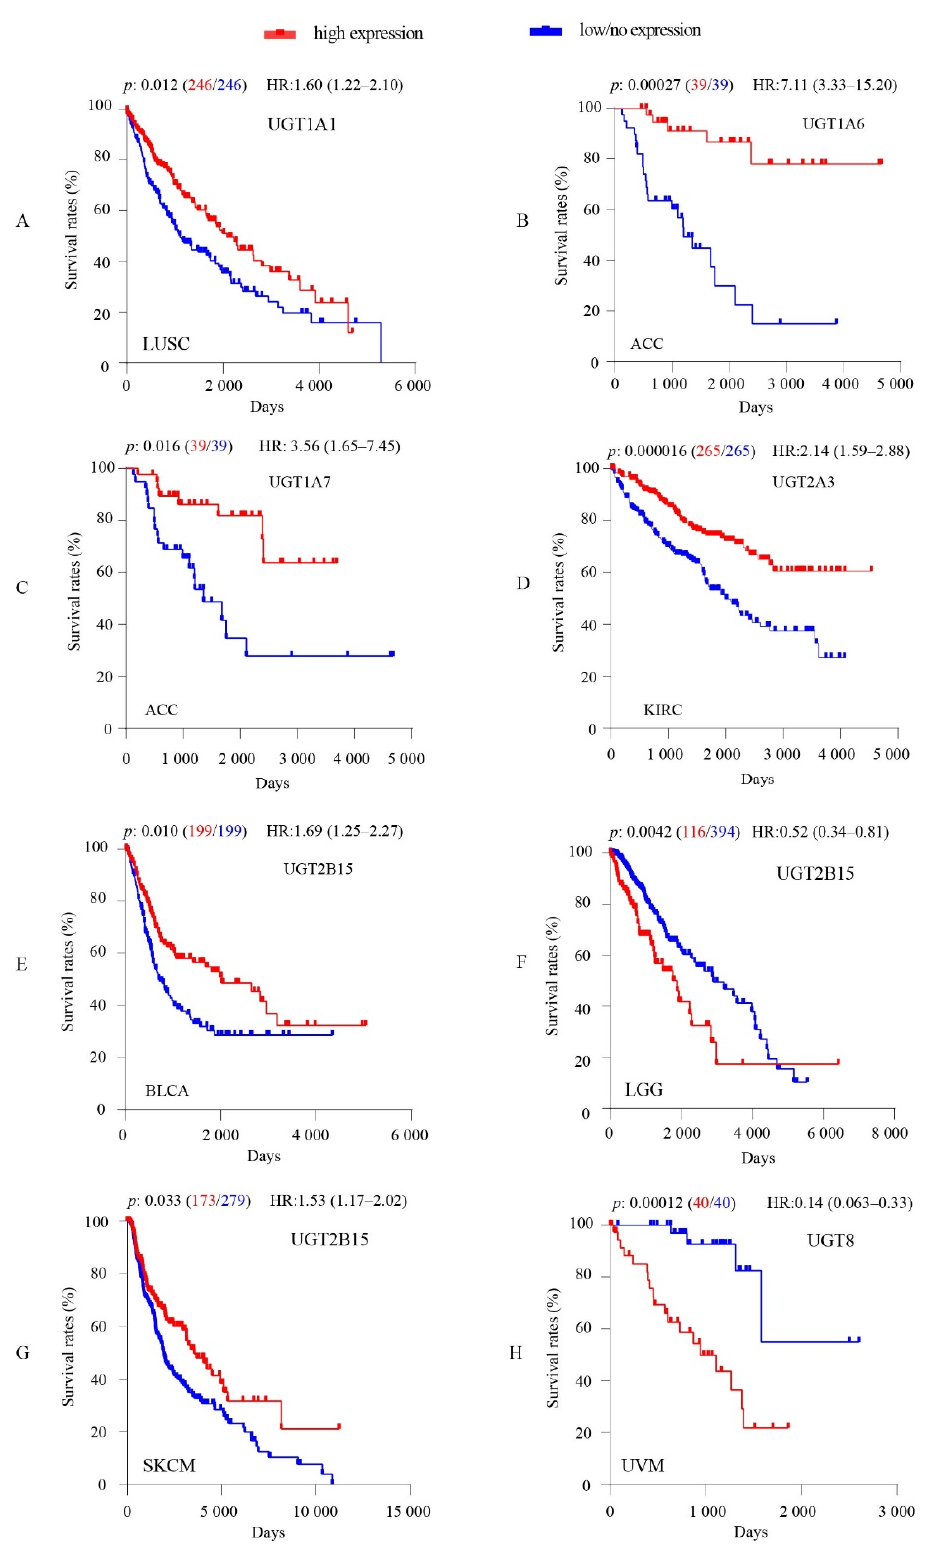
and maximum) in each of these cancers. Up/downregulated UGT genes are highlighted with * indicating an adjusted p -value of <0.01.